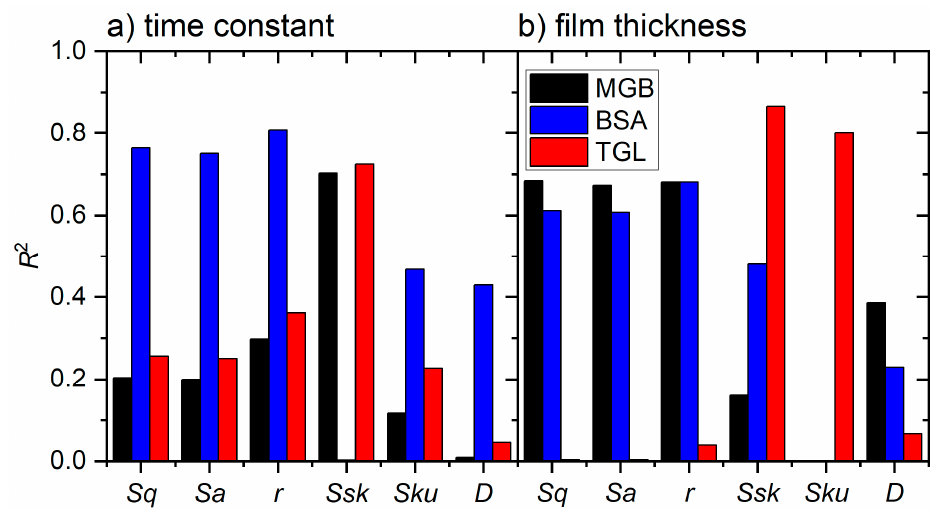
Figure 4. R ² values of the linear fits to the time constant data in Figure 3 ( a ) and the film thickness data in Figure 5 ( b ). The individual R ² values are listed in Tables S5 and S6, respectively.